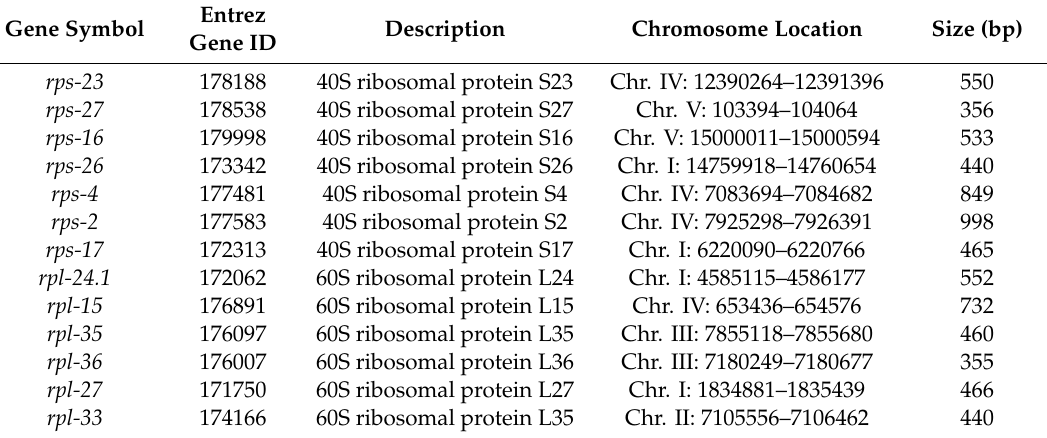
Table 1. Reliable housekeeping gene candidates of C. elegans identified in this study.